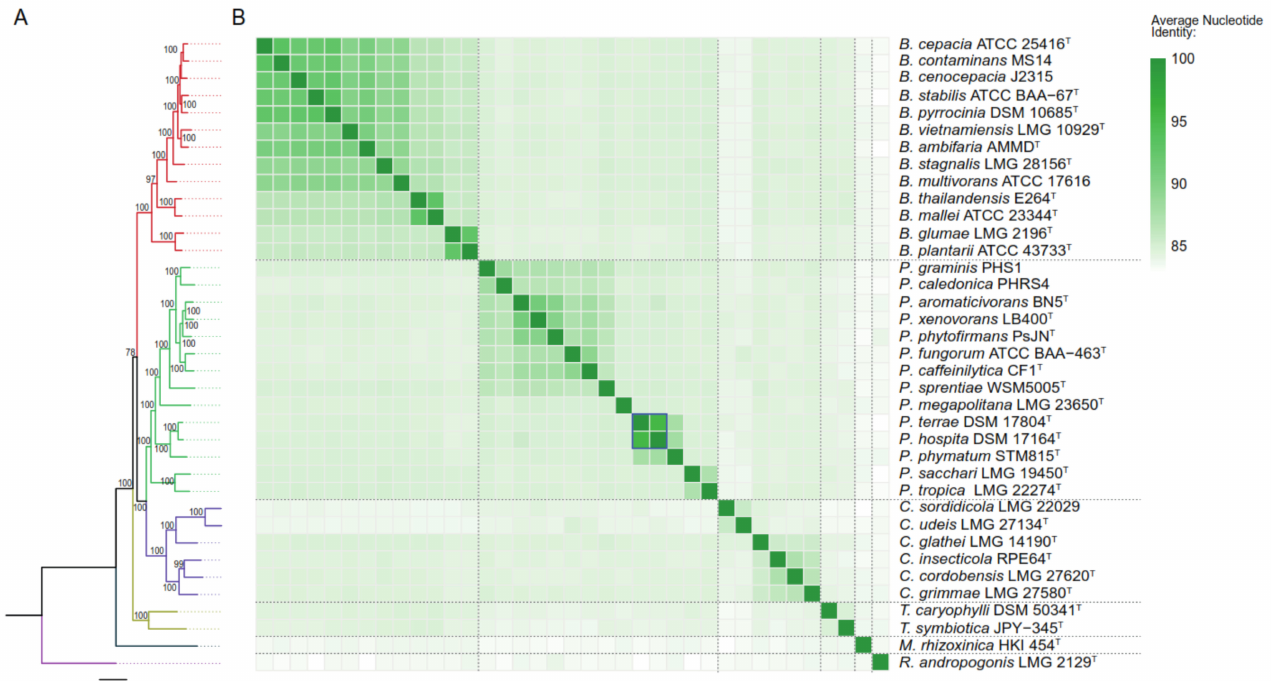
Figure 1. Phylogenomic placement of the 37 Burkholderia sensu lato genomes used in this review. ( A ), phylogenomic tree of Burkholderia sensu lato strains based on 38 core genes (Phylophlan software); ( B ), Average Nucleotide Identity based on Mummer (ANIm) analysis of Burkholderia sensu lato